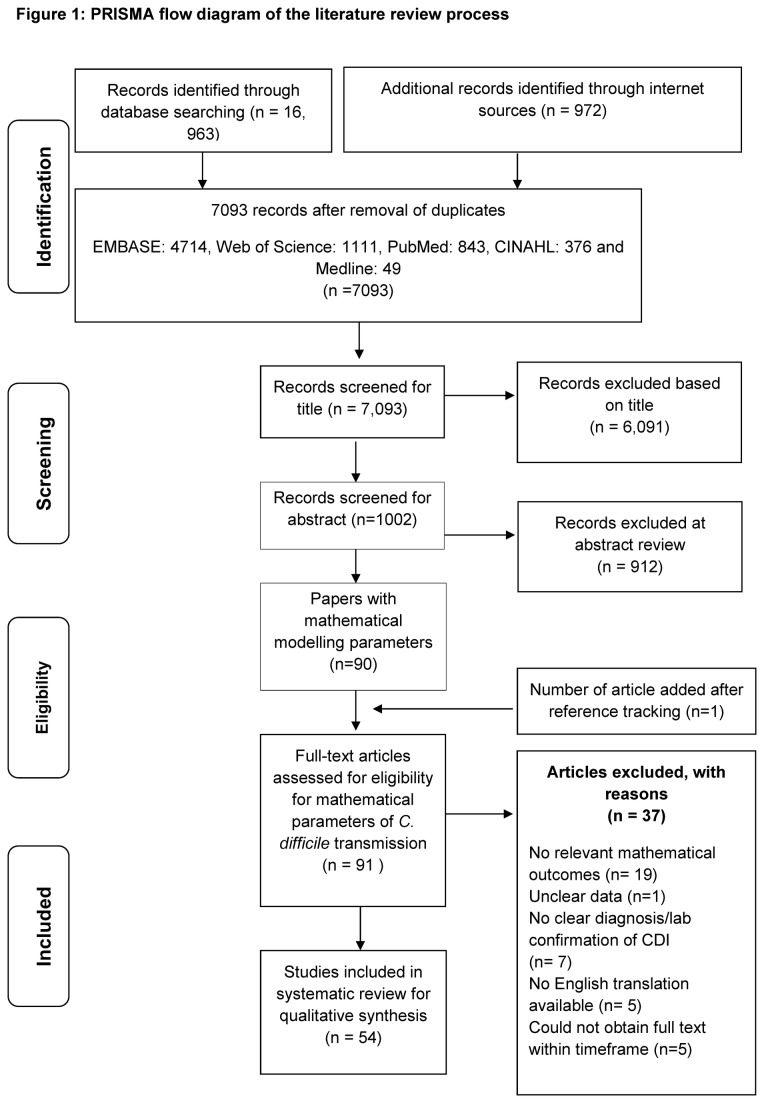
PRISMA flow diagram of the literature review process.